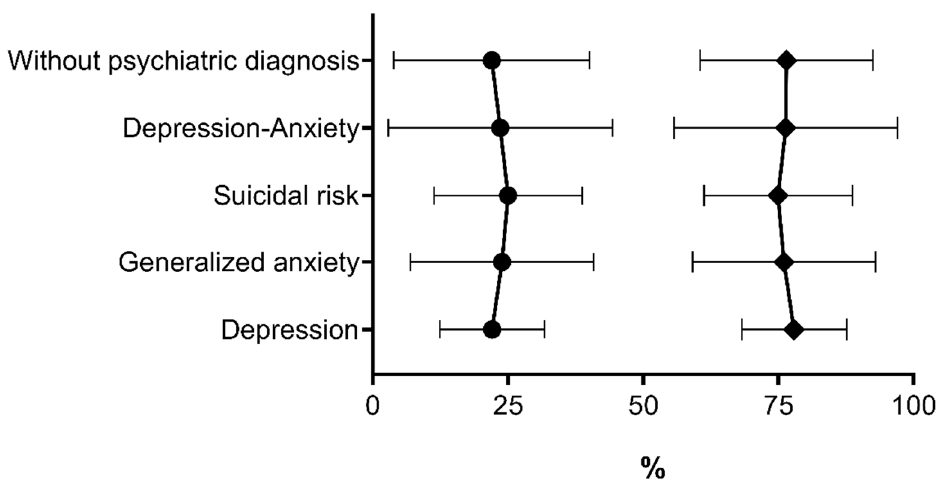
Figure 1. Comparison levels of % inhibition ( • ) and AChE activity ( ♦ )% of the exposed participants. Data are represented as the mean ± SD.